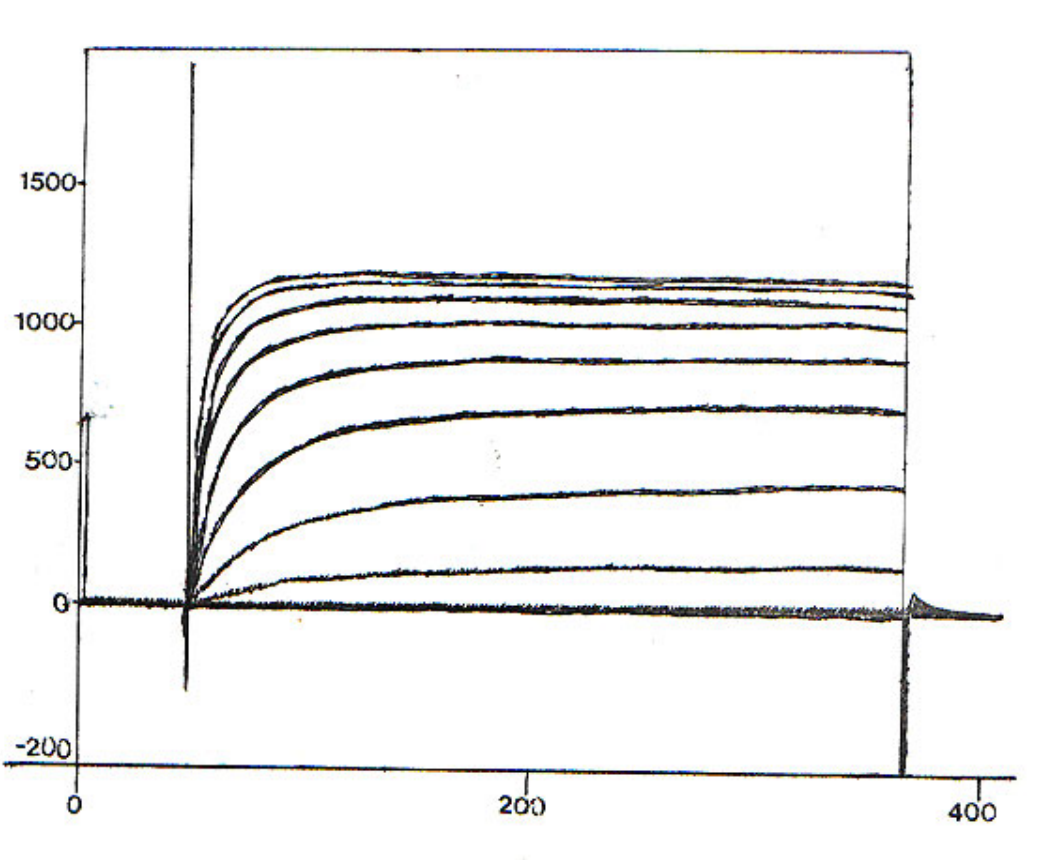
Figure 6a: Control oocytes before the addition of Palamneus gravimanus toxin at +10 mV (the maximum current is 1098